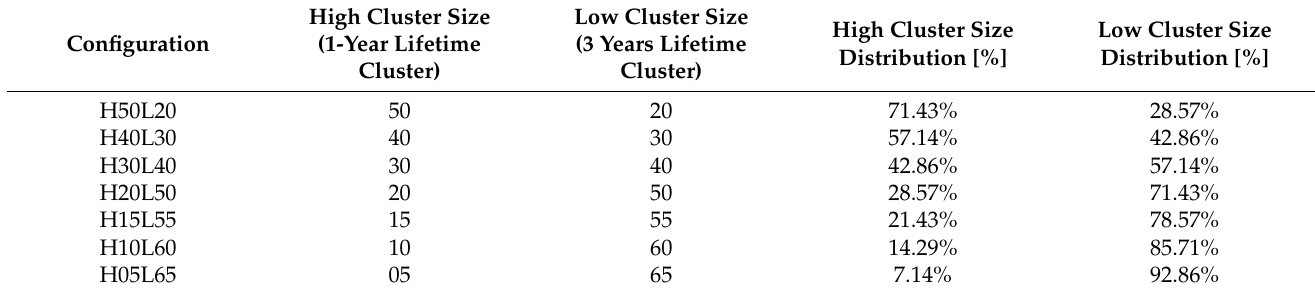
Table 3. The distribution of the field devices per each profile